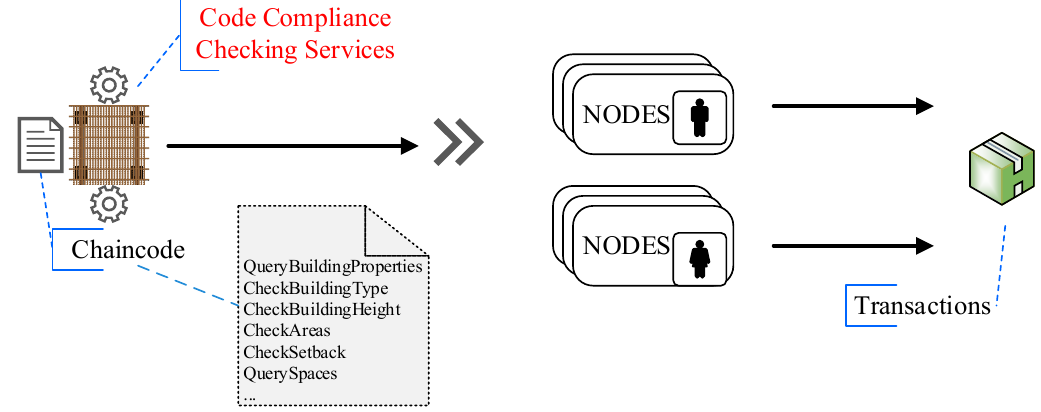
Figure 12. Constructing blocks of the results.